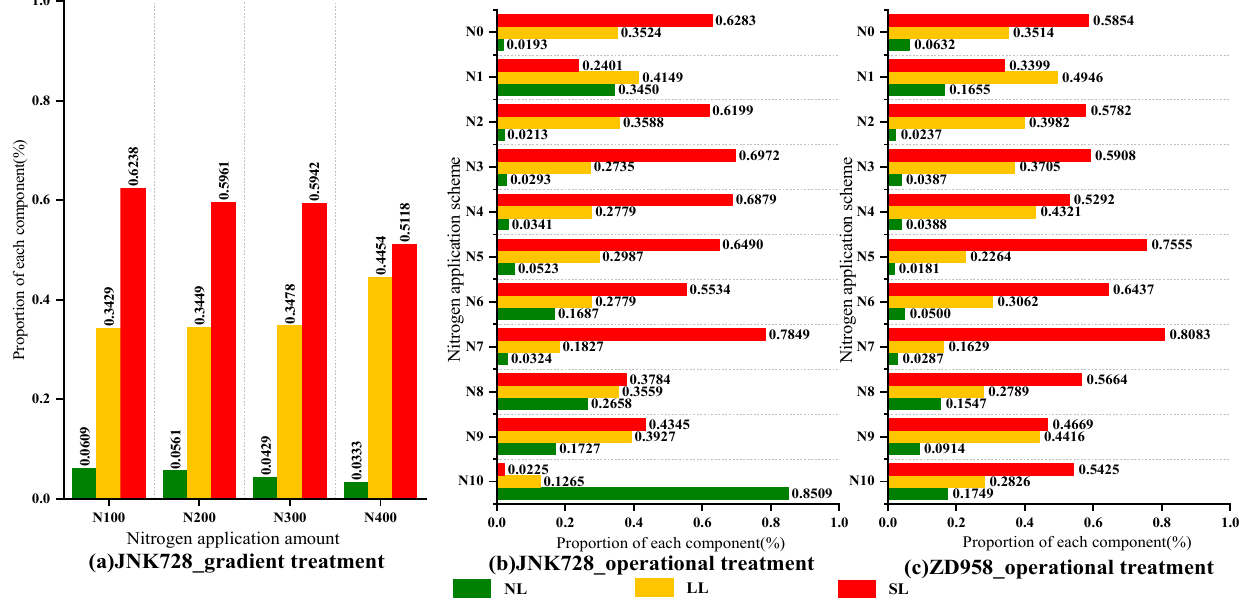
Figure 19. Distribution of different degrees of lodging in nitrogen-experimental field. The nitrogen experimental field with the gradient treatment (operational treatment) is on the left (right). The numbers on the bar charts indicate the percent of the given degree of lodging in the experimental cell.